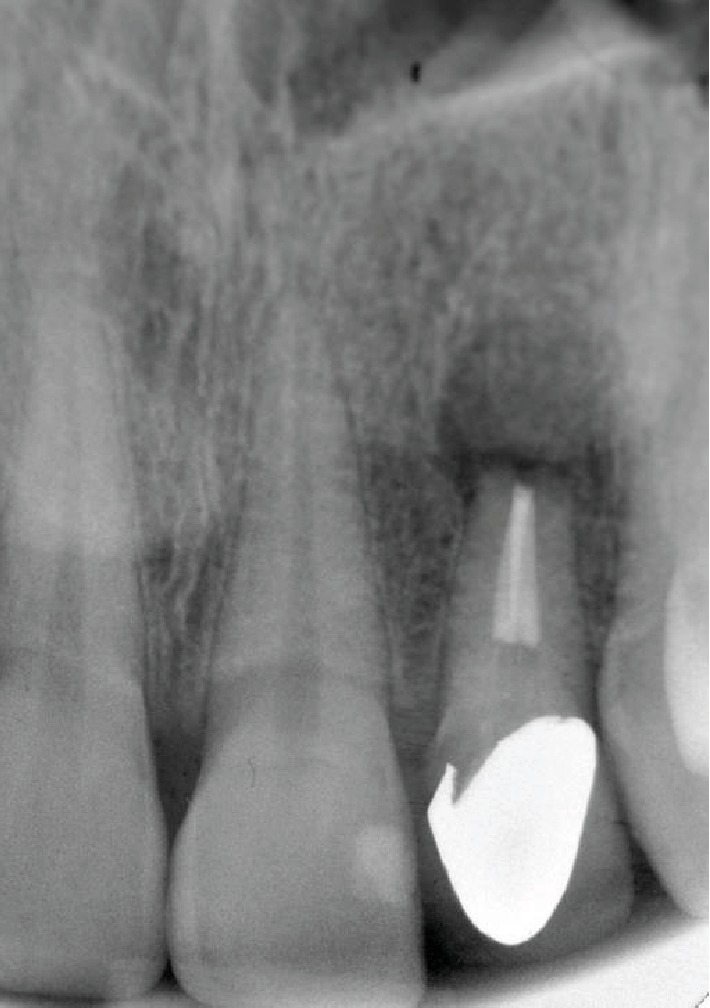
Preoperative X-ray.